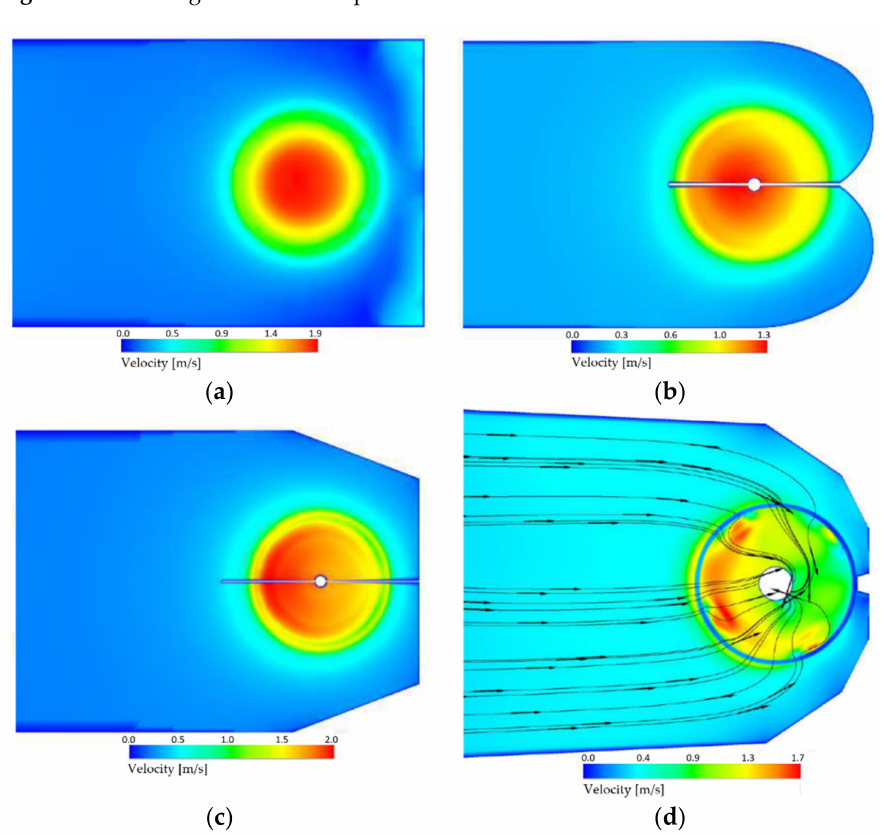
Figure 16. Velocity distribution at the suction bellmouth for all test cases: ( a ) case 1, ( b ) case 2, ( c ) case 3, ( d ) case 4. Notice the uneven velocity distribution for case